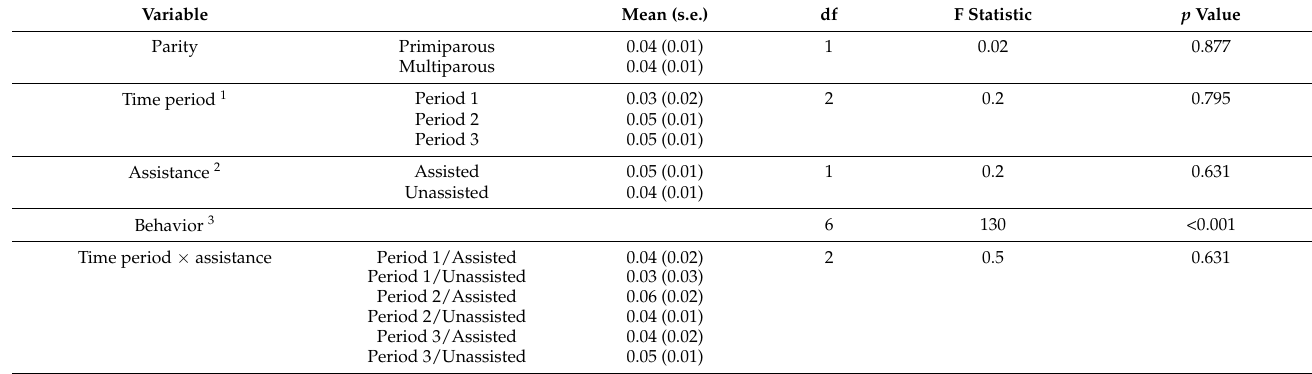
Table 1. Effects of parity, time period and calving assistance on the duration of dairy cow ( n = 35) behaviors as a proportion of time. Variable Mean (s.e.)